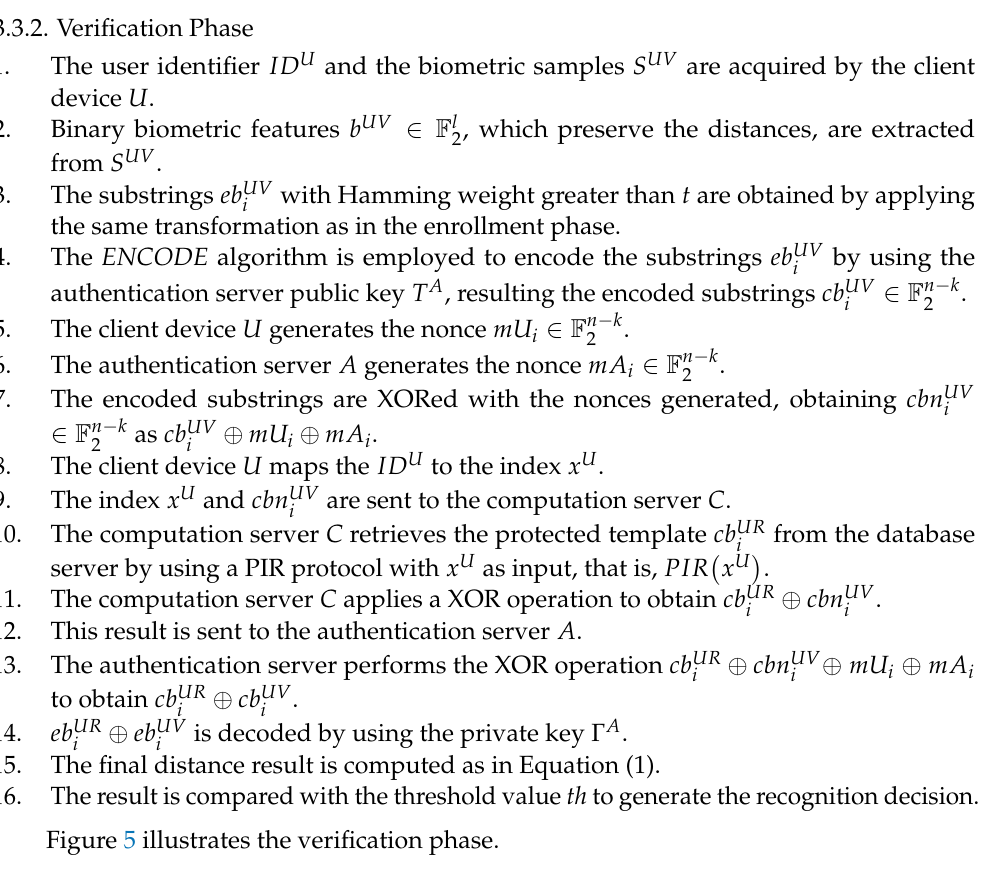
Figure 4. Setup and enrollment phases of the distributed authentication protocol based on the Classic McEliece protection proposed.